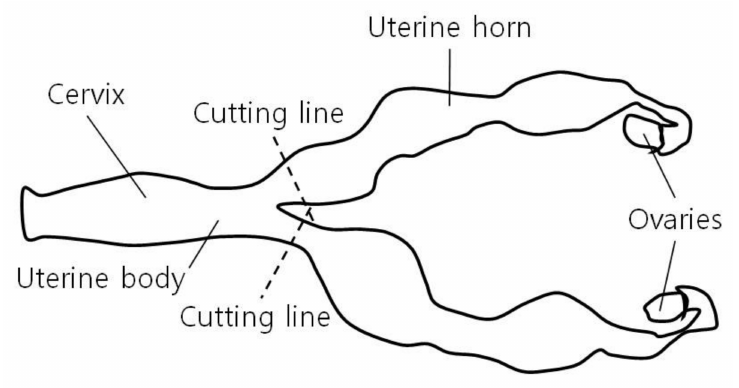
Figure 4. Cutting lines for removal of the uterine horns (spot lines). The uterine horns were removed as much as possible through the incision (a partial ovariohysterectomy). The parts of the left and right uterine horns remaining in the abdominal cavity were sutured using the Parker-Kerr technique.